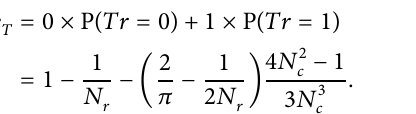
Figure 8: Minimized system cost versus demand levels with different input parameters. (a) 𝜏 = 24 s. (b) v 𝜇 = 80 $ /